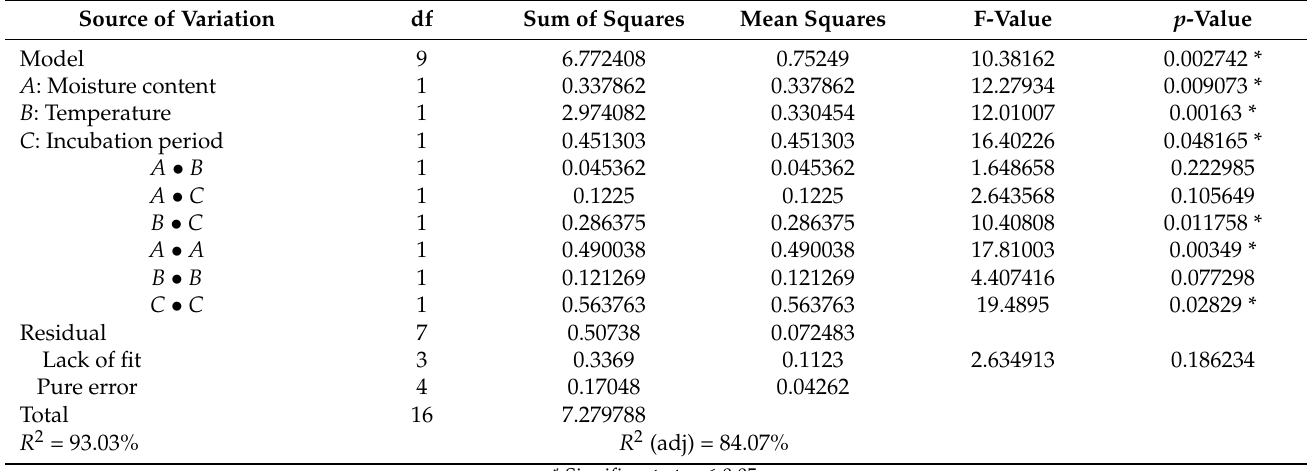
Table 9. ANOVA analysis for response surface quadratic model of T. asperellum AU131.